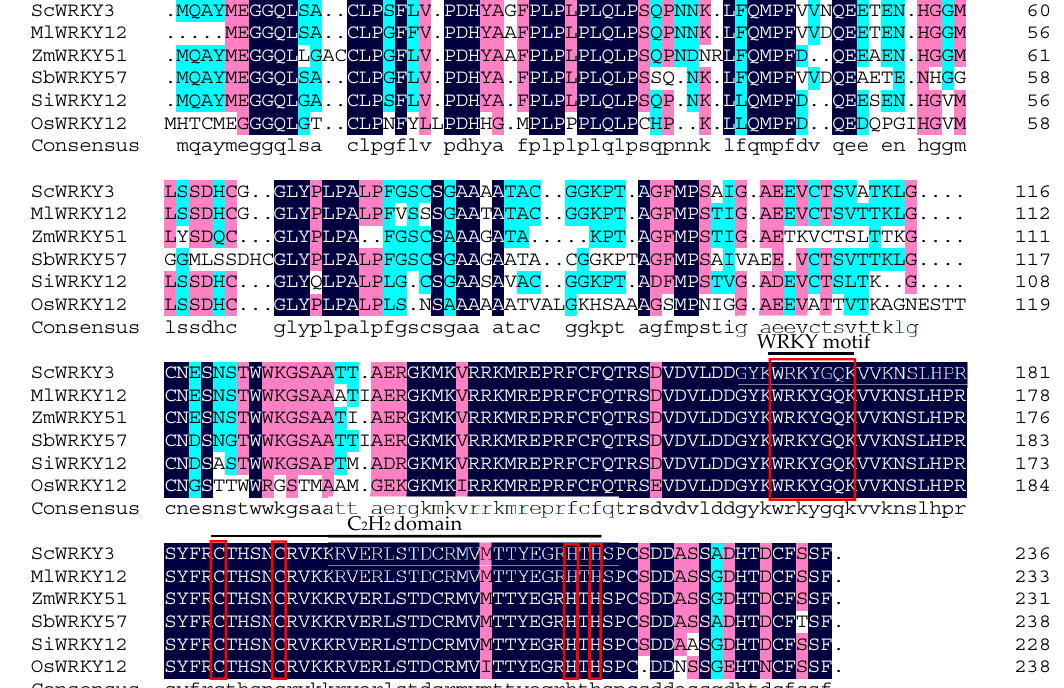
Figure 2. Amino acid sequence alignment of ScWRKY3 and WRKYs from other plant species by DNAMAN (version 6.0.3.99, Lynnon Biosoft) software. The amino acid sequences of Miscanthus lutarioriparius MlWRKY12 (AGQ46321.1), Zea mays ZmWRKY51 (XP_020393361.1), Sorghum bicolor SbWRKY57 (XP_002452824.2), Setaria italica SiWRKY12 (XP_004953301.1), and Oryza sativa OsWRKY12 (XP_015624962.1) are from GenBank. The black, pink, blue, and white colors indicate the homology level of conservation of the amino acid residues in the alignment at 100, ≥ 75, ≥ 50, and <50%, respectively. The sequences of the WRKY motif (WRKYGQK) and the C 2 H 2 domain (C X4 C X23 H X H) are highlighted by the red rectangle.